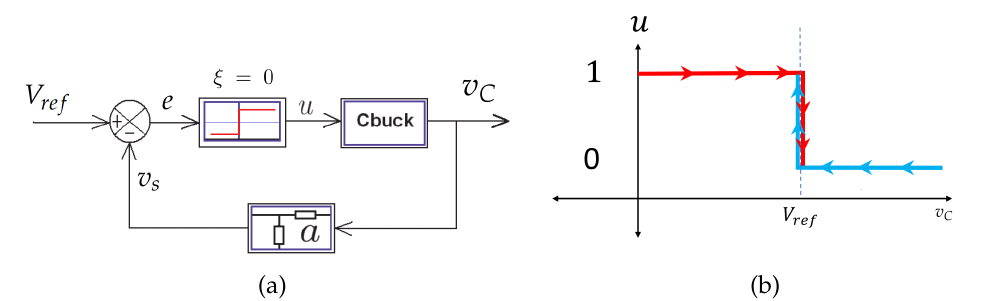
Figure 7. Hysteresis control applied to the Buck converter ( a ) block diagram with the zero hysteresis control and ( b ) switching state for the zero hysteresis control ( ξ = 0